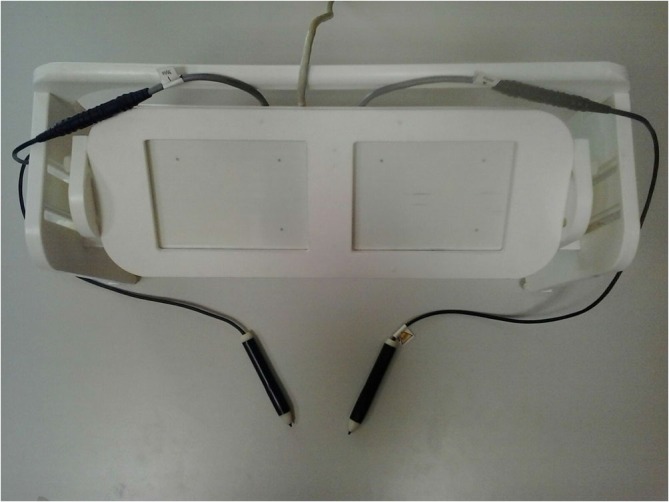
Dual panel functional Magnetic Resonance Imaging (fMRI)-compatible tablet.